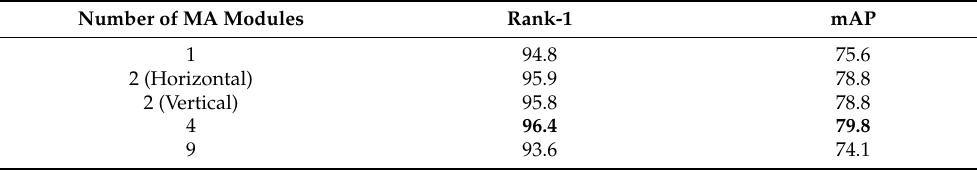
Table 6. The impact of the number of part features N p on VeRi-776 [3] dataset.